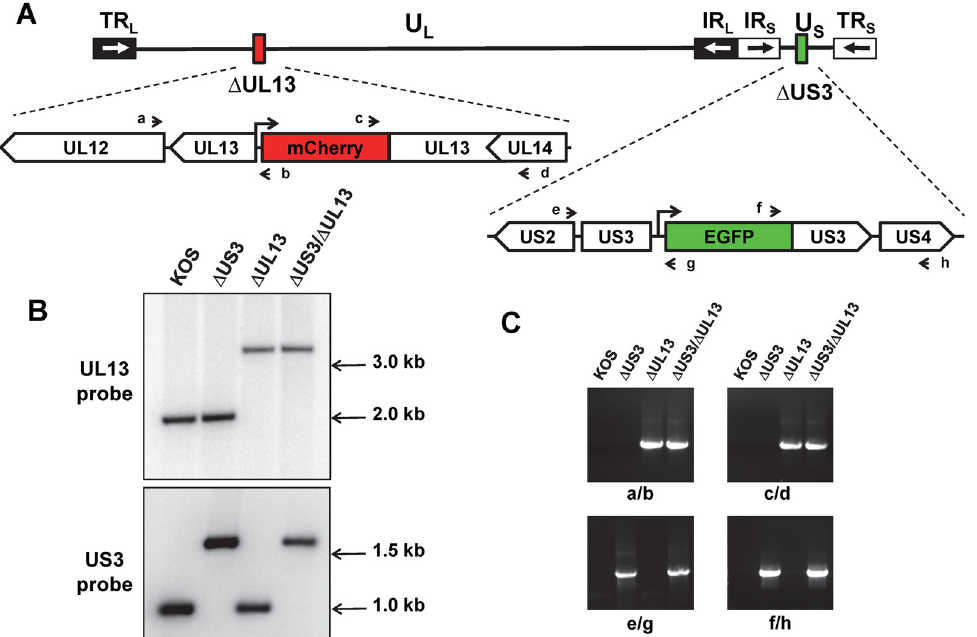
Fig 1. Construction and analyses of mutant US3 and UL13 alleles. (A) Schematic representation of the HSV-1 genome. Unique DNA sequences are represented by horizontal lines, and inverted repeats flanking the unique sequences are shown as open and black boxes with black and white arrows, respectively. US3 and UL13 regions where mutant alleles were generated are enlarged and position of the mCherry and GFP cassettes shown as red and green boxes, respectively. The approximate positions of primers designated a, b, c, d, and e, f, g, h used for PCR analyses are shown as short black arrows. (B) Southern blotting analyses of HSV-1 Δ US3 , Δ UL13 , and Δ UL13/ Δ U3 mutants. Viral DNA preparations from Vero cells infected with wild type KOS or mutant viruses were digested with Afl II (top panel) and Mlu I (bottom panel) and subjected to Southern blotting. Membranes were probed with 32 P-labeled UL13- and US3-specific oligonucleotide probes (S1 Table). Positions of DNA size standards are shown on the right. (C) PCR analyses of HSV-1 Δ US3 , Δ UL13 , and Δ UL13/ Δ US3 mutants. Total DNA isolated from Vero cells infected with wild type HSV-1 KOS or mutant viruses were used as template for PCR reactions with 4 sets of primers. In each set, one primer is located outside of the region involved in homologous recombination and another primer is located within the mCherry or GFP cassettes. The PCR reactions were resolved on 1.2% agarose gels and visualized by ethidium bromide staining.